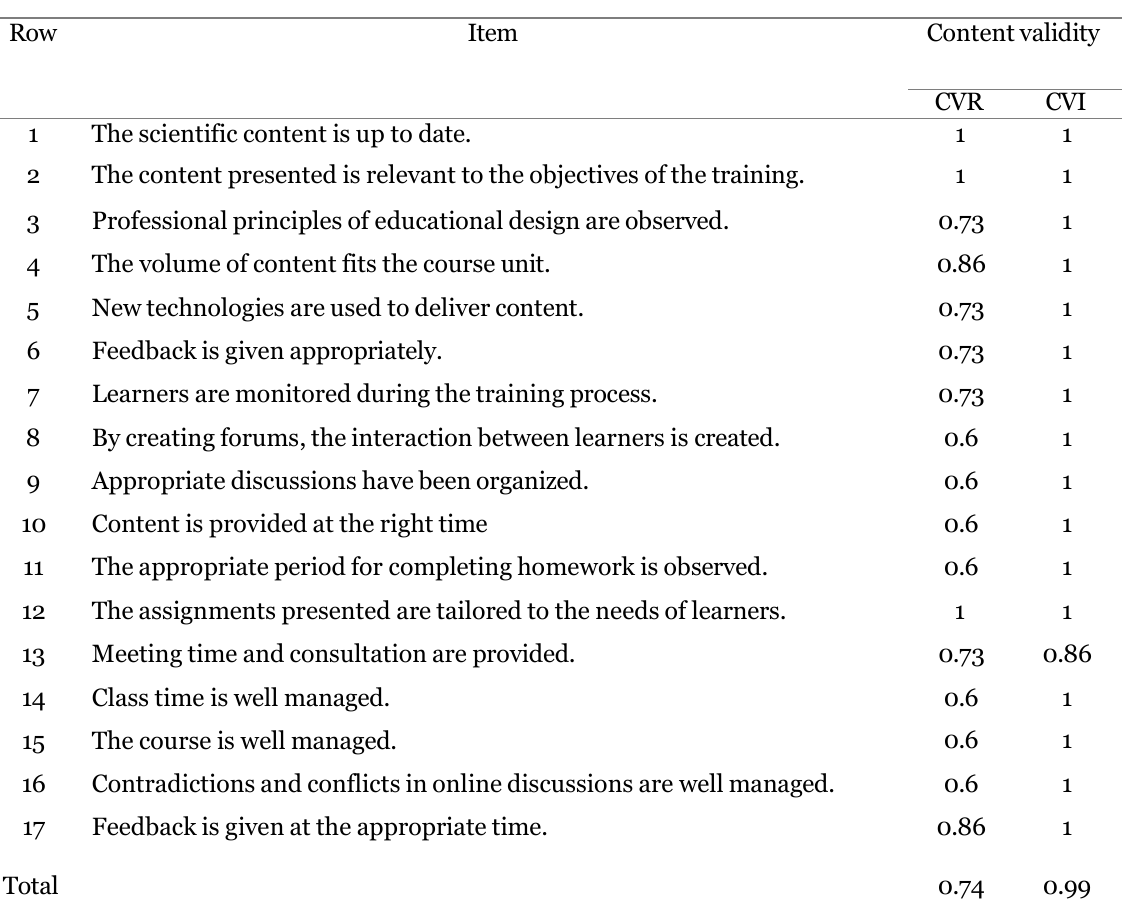
Initial CVR and CVI Values of Peer Review Checklist